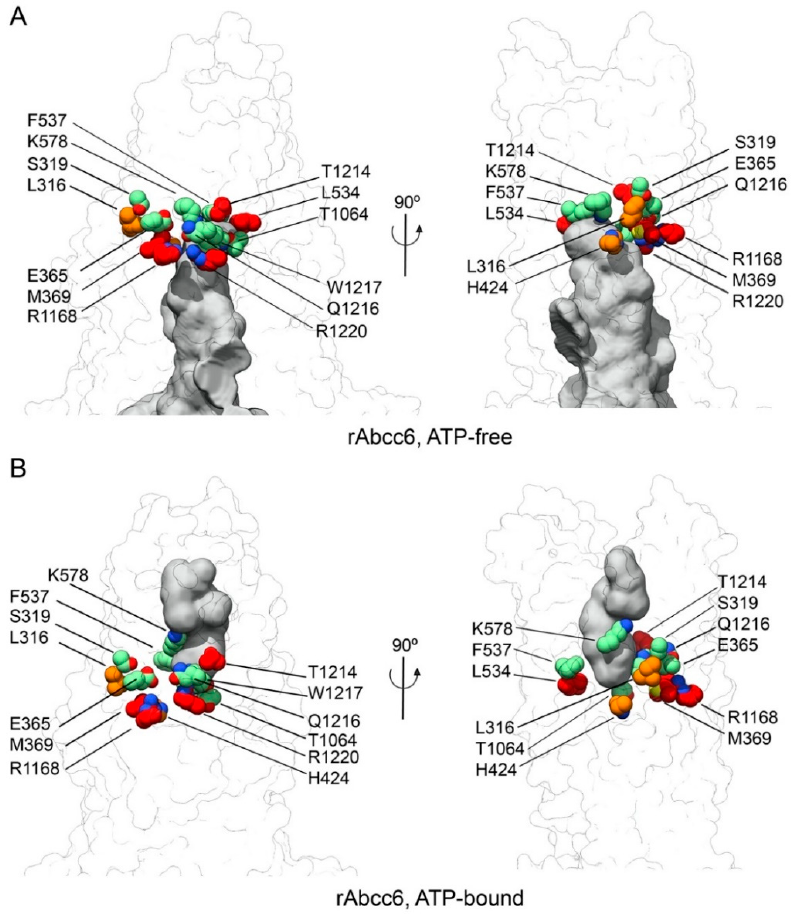
Figure 5. Mutation of the amino acids forming the modelled rAbcc6 substrate-binding cavity affect ATP efflux to different degrees. View of the ( A ) ATP-free inward-facing and ( B ) ATP-bound, outward-facing models of rAbcc6. rAbcc6 residues that when mutated abolished and reduced ATP efflux are shown as red and orange spheres, respectively. Residues that once mutated did not affect ATP efflux are shown as green spheres. The protein is shown as a white transparent surface and the volume of the main cavity in both models is shown as a gray surface. The volume was calculated with the 3V webserver